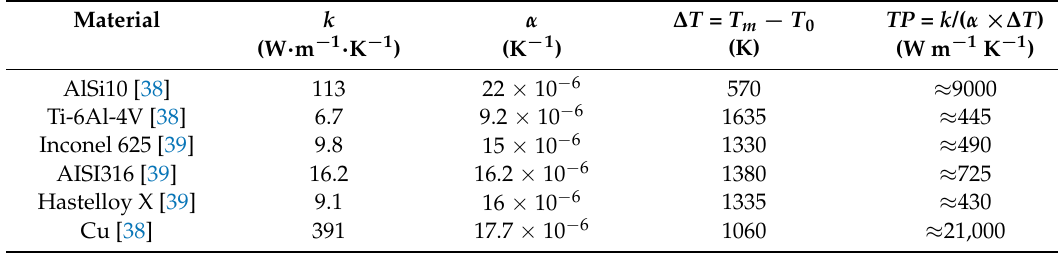
Table 2. Characteristic values for k , α , and ∆ T = T m − T 0 and corresponding evaluation of TP for some metals of interest in laser-based powder bed fusion (L-PBF)